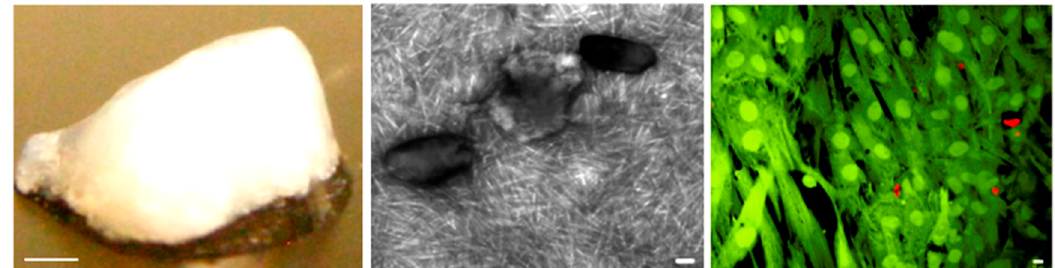
Figure 5. ( left ) Macroscopic, ( middle ) TEM, and ( right ) confocal images of PA-RGDS/PA-S (1:1) hydrogel with 50 wt% HAp. The right image shows encapsulated hMSCs, viable and dead cells appearing in fluorescent green and red colors, respectively. Scale bars correspond to 1 mm ( left ), 100 nm ( middle ), and 10 µ m ( right ). Reproduced from [102].